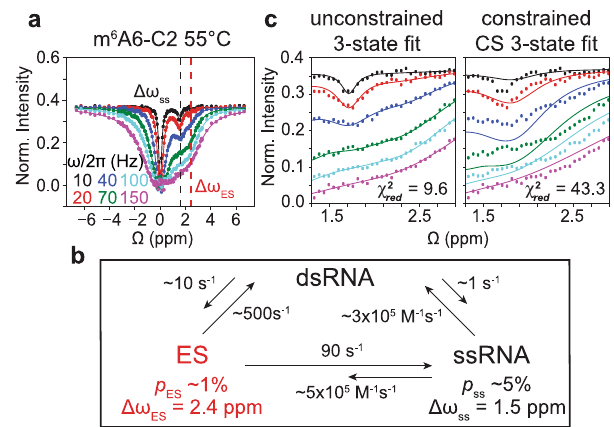
Fig. 3 A hybridization intermediate for dsGGACU m 6 A6 at T = 55 °C. a 13 C CEST pro fi le for m 6 A6 C2 in dsGGACU m 6 A6 at T = 55 °C shows a second dip at Δ ω ES that is distinct from the ssRNA ES at Δ ω ss . b Exchange parameters (Supplementary Table 3) from a three-state fi t to the RD data using a triangular model. c Zoom in to the m 6 A6 C2 CEST pro fi les comparing results from an unconstrained three-state fi t to the Bloch – McConnell equations assuming the triangular model and a constrained three-state fi t assuming a linear CS model. Data for CEST pro fi les were presented as mean values± 1 s.d. (smaller than data points) from n = 3 independent measurements of peak intensities at zero relaxation delay (see “ Methods ”